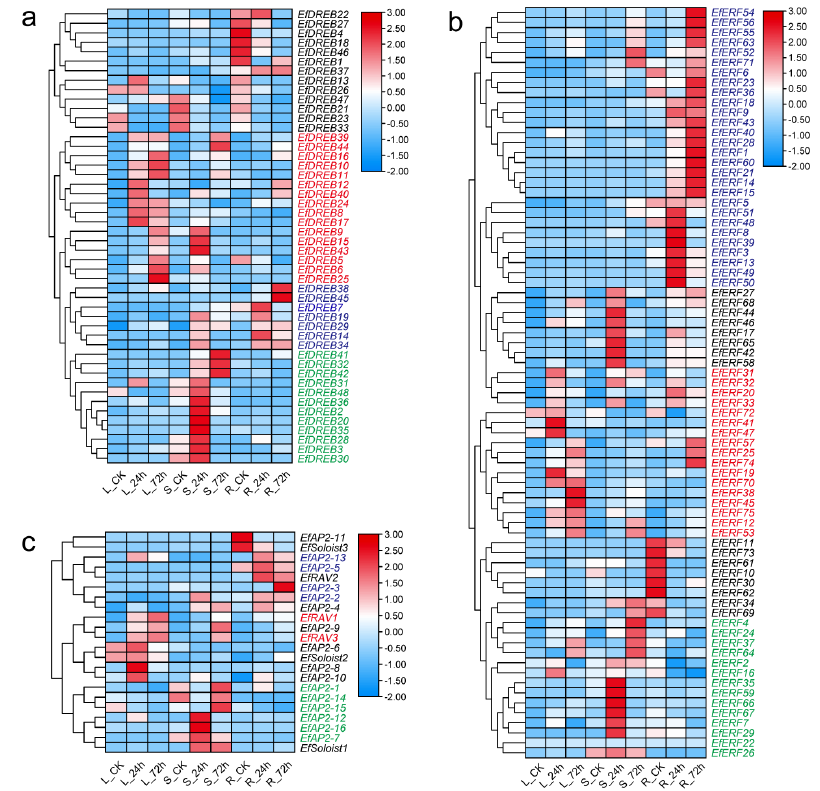
Figure 10. Expression profile of EfAP2/ERF genes in different tissues (leaves (L), roots (R), and stems (S)) and under low-temperature (4 ◦ C) stress (0, 24, and 72 h). ( a ) Expression profile of EfDREB genes. ( b ) Expression profile of EfERF genes. ( c ) Expression profile of EfAP2 , EfRAV , and EfSoloist genes. For each line, the expression patterns are presented as heatmaps in blue/white/red boxes, with red indicating high expression level, white indicating moderate expression level, and blue indicating low expression level. The red/green/blue gene names indicate that these genes were upregulated by cold stress induction in leaves, stems, and roots,